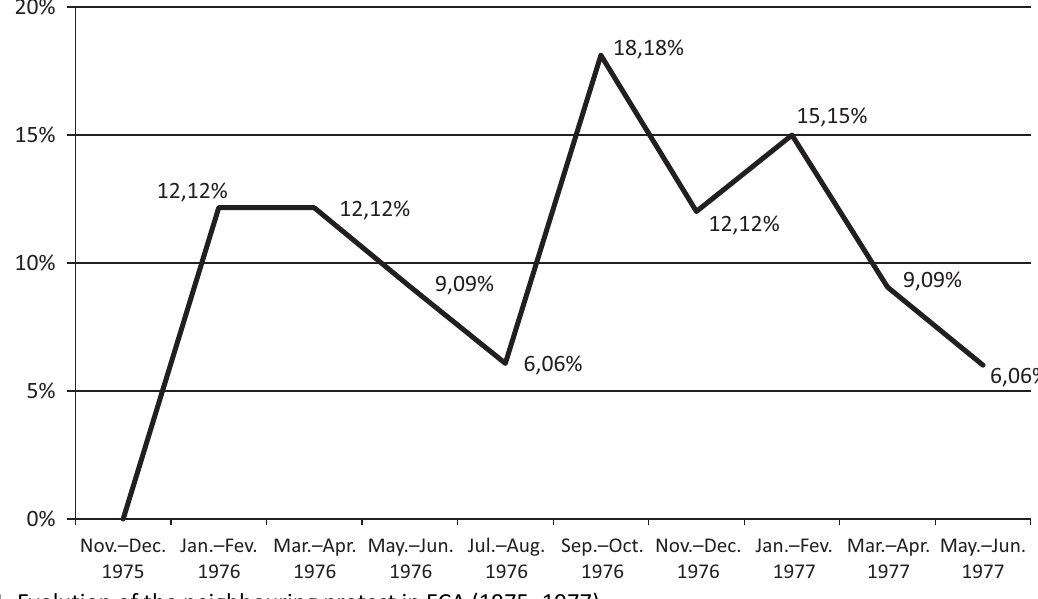
Figure 1. Evolution of the neighbouring protest in ECA